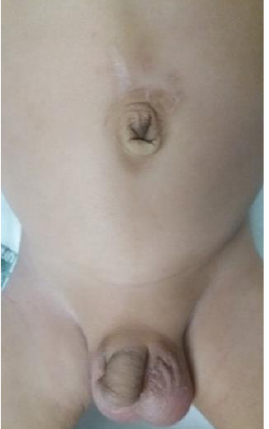
Figure 1 . Supra-umbilical incision for peritoneal catheter implant. Note the slight testicular asymmetry with swelling on the left